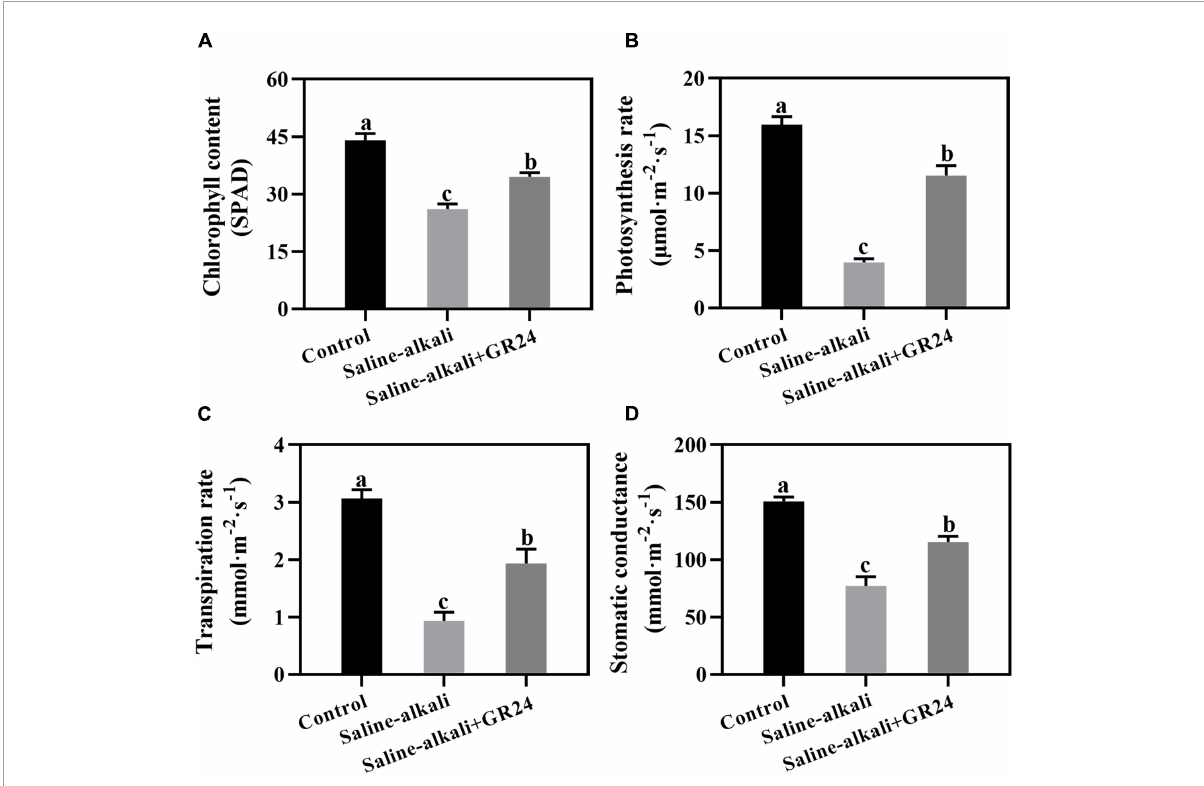
FIGURE2 Effects of exogenous GR24 application on the chlorophyll content (A) , photosynthetic rate (B) , transpiration rate (C) and stomatic conductance (D) of Malus hupehensis seedlings after salinity-alkalinity stress for 15 days. The data represent the mean ± SD of three biological replicates. Different lowercase letters indicate significant differences according to Fisher’s least significant difference ( P <